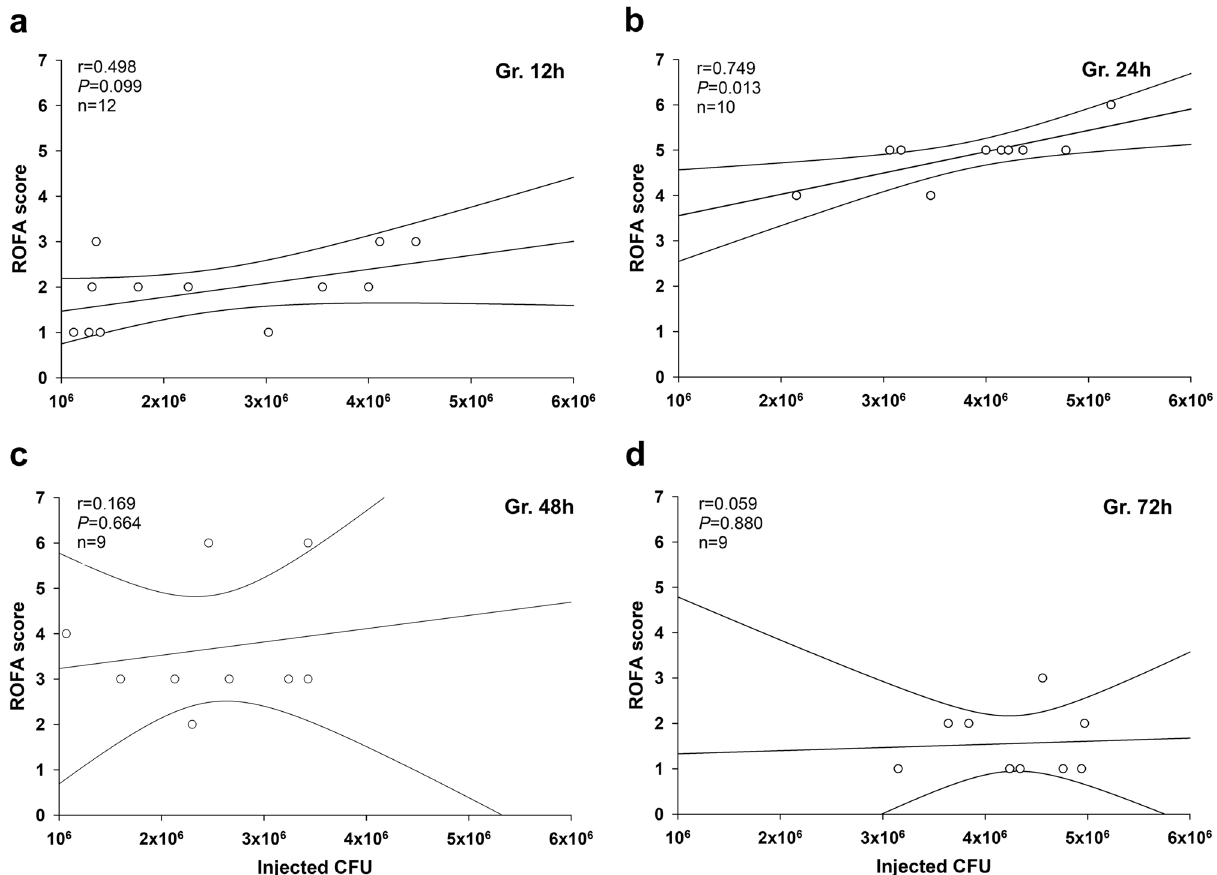
Figure 6. Correlation between CFU values of the inducer inoculum and ROFA scores. Values are shown in the 12 h (a) , 24 h (b) , 48 h (c) and 72 h (d) polymicrobial sepsis groups. The number of animals used in the various sepsis groups is indicated in Table 1. Pearson’s product correlation coefficient r values and (null hypothesis- related) P values are provided, and regression lines and 95% confidence intervals are